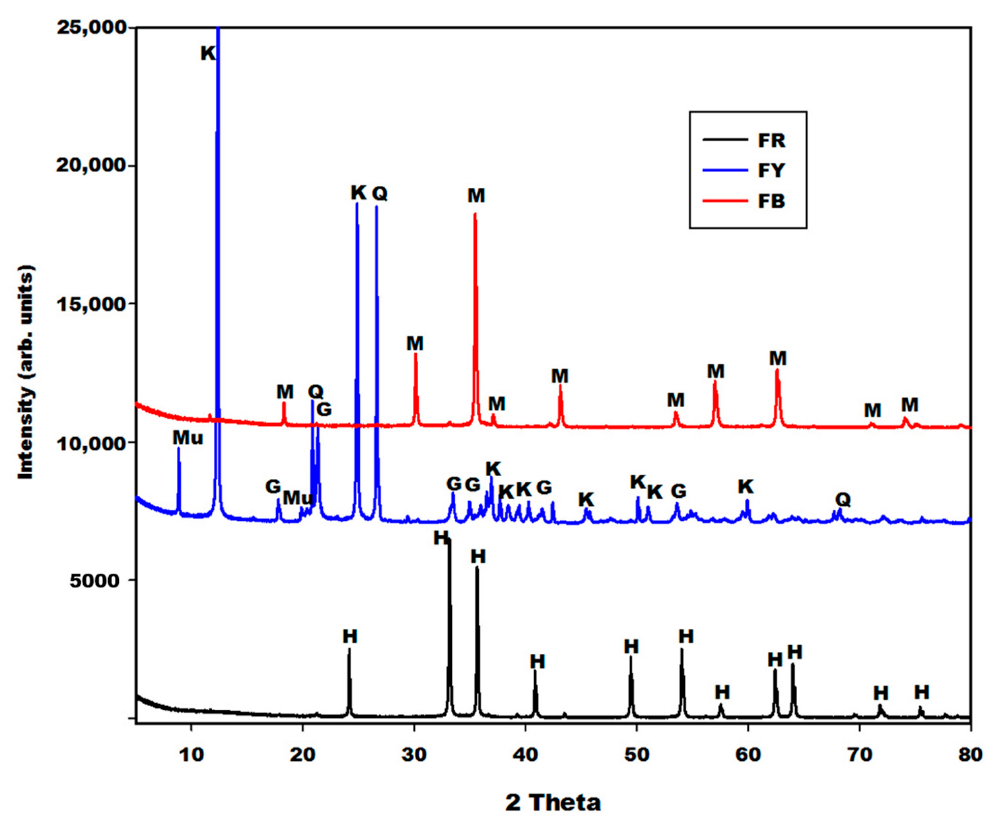
Figure 1. X-ray patterns of different oxides (FR, FB and FY). Q, H, M, G, Mu and K denotes the peaks of quartz, hematite, magnetite, goethite, muscovite and kaolinite, respectively.